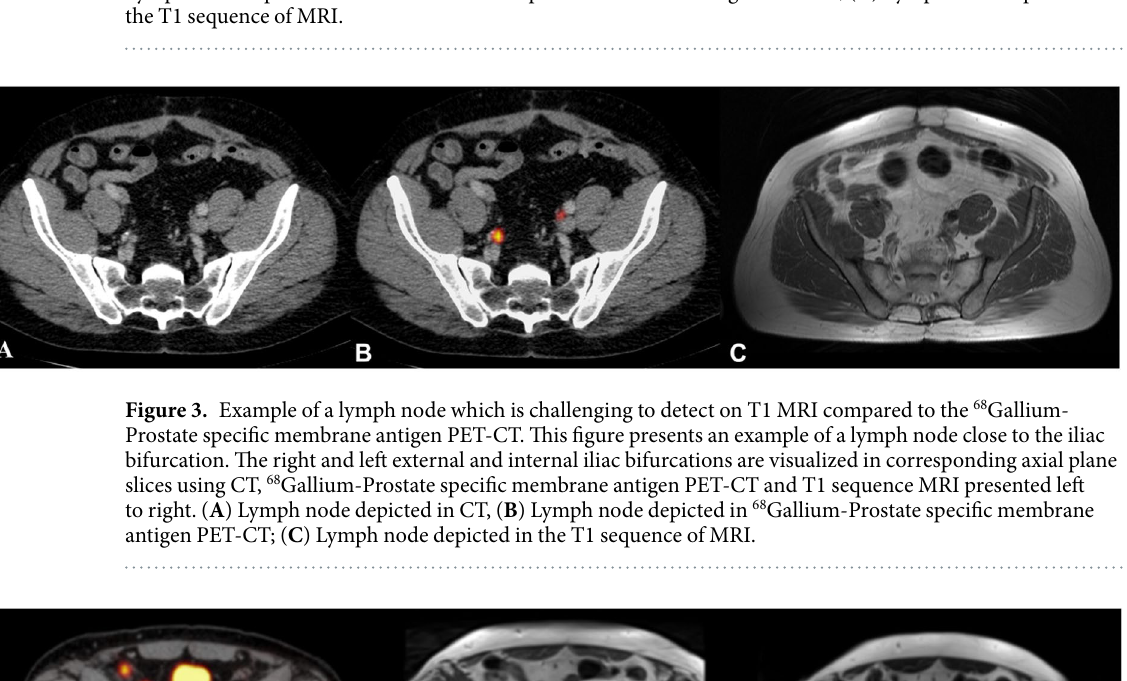
Figure 2. Example of a lymph node which is directly detectable on T1 MRI and 68 Gallium-Prostate specific membrane antigen PET-CT. This figure shows a lymph node (LN) which is directly detectable on T1 MRI and 68 Gallium-Prostate specific membrane antigen PET-CT. This large suspect LN is located at the right external iliac artery. The LN is visualized in corresponding axial plane slices using CT, 68 Gallium-Prostate specific membrane antigen PET-CT and T1 sequence MRI presented left to right. ( A ) Lymph node depicted in CT, ( B ) Lymph node depicted in 68 Gallium-Prostate specific membrane antigen PET-CT; ( C ) Lymph node depicted in the T1 sequence of MRI.